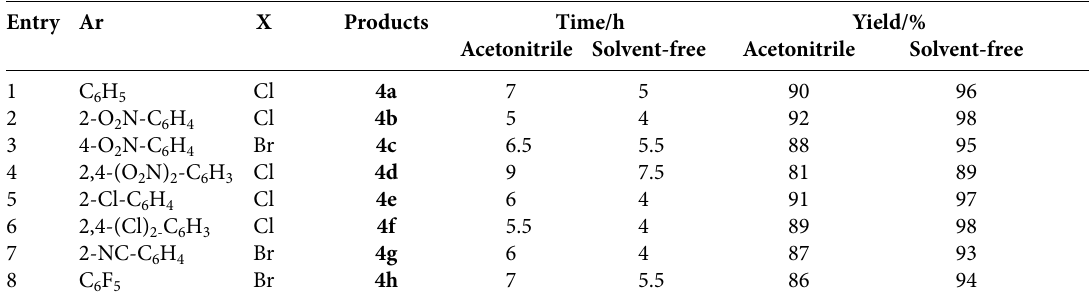
Table 1. Multicomponent synthesis of thioethers 4a–h in acetonitrile or under solvent-free conditions. Entry